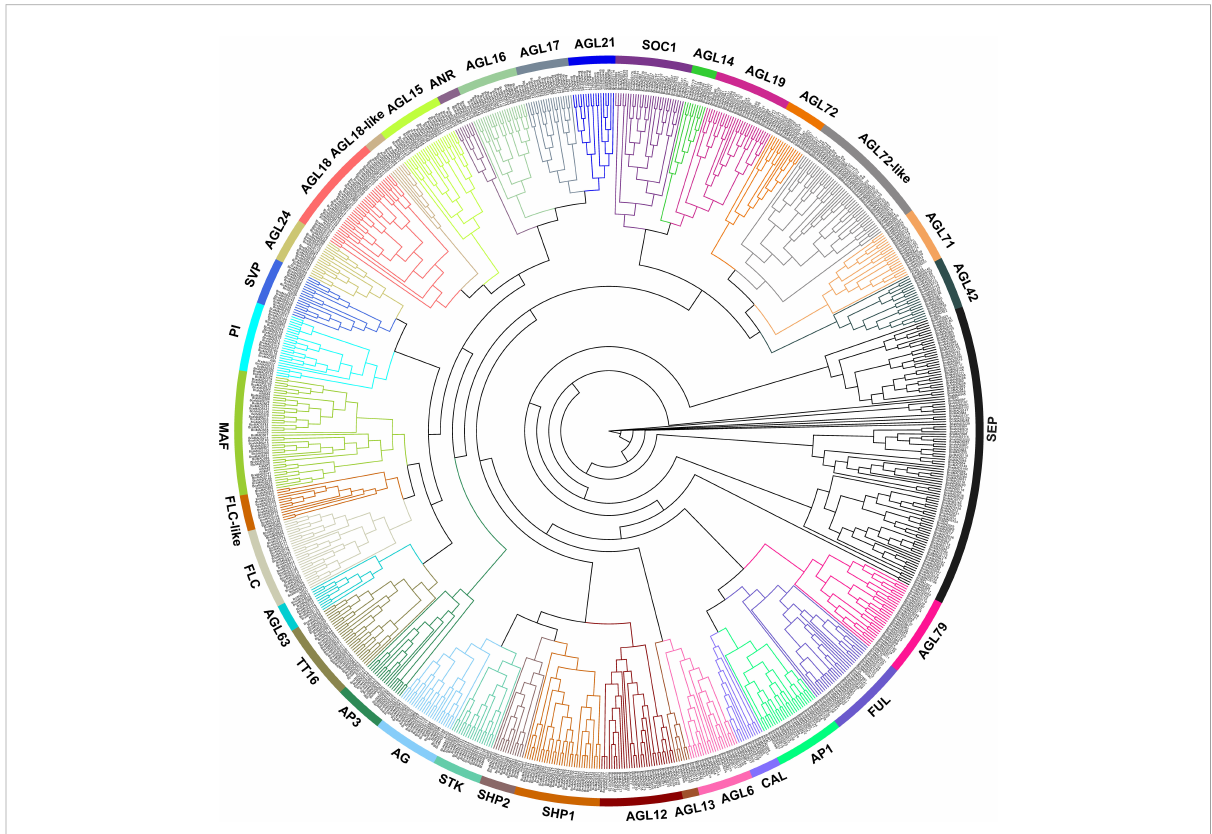
FIGURE 2 Neighbor-joining (NJ) tree of MIKC-type MADS-box genes identi fi ed in the six U ’ s triangle species; the genes were divided into 35 subgroups. Different colors represent different